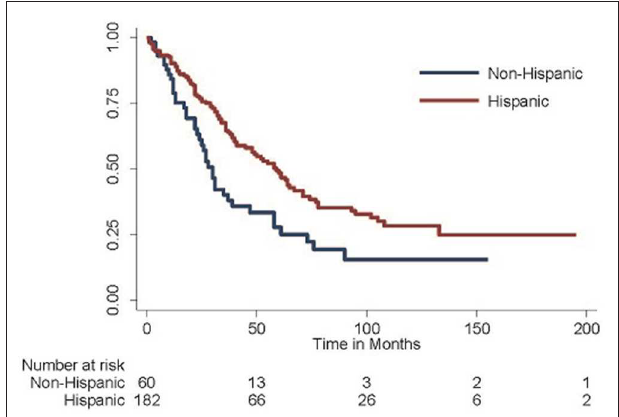
FIGURE 1 | Overall survival among Hispanic-Caribbean. Among women born in the Caribbean with epithelial ovarian cancer, those of Hispanic ethnicity do